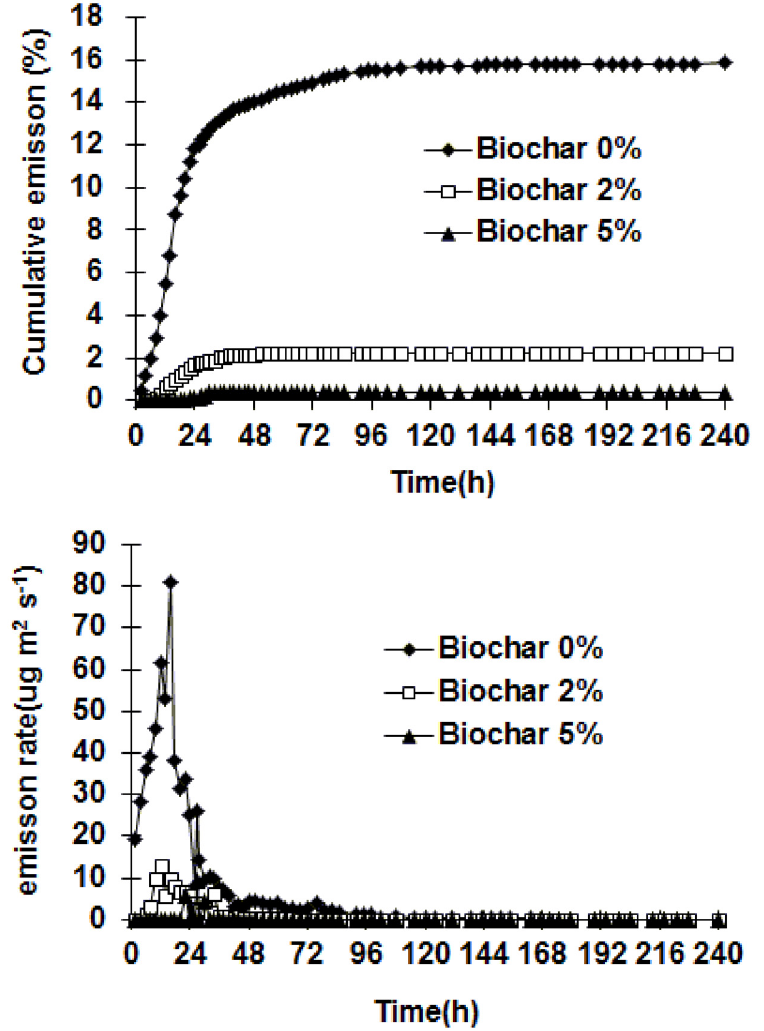
Fig 3. Emission rates and cumulative emissions of CP in soil column